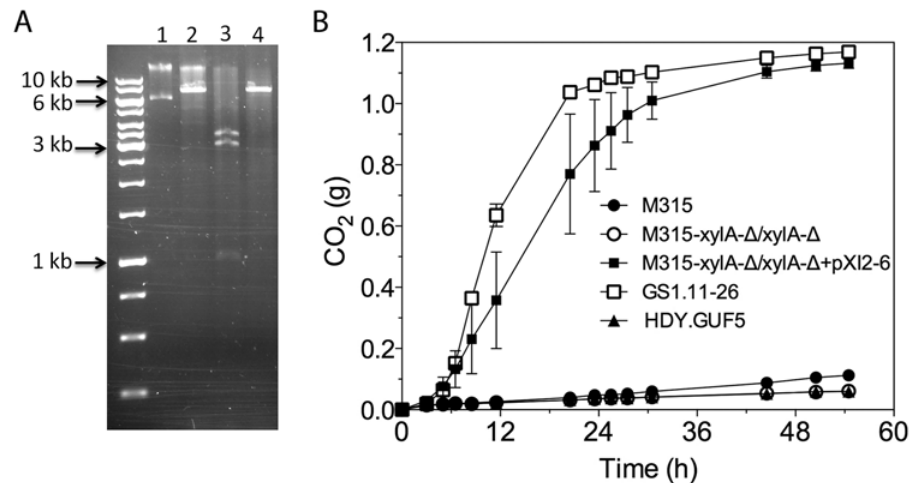
Fig 7. Restriction analysis and xylose fermentation conferring capacity of plasmid pXI2 – 6. (A) Restriction analysis of pXI2 – 6. Lane 1, undigested plasmid showing two bands that stand for the supercoiled (lower band) and nicked (upper band) structure; lane 2, Xho I digestion which has single restriction site but shows incomplete digestion; lane 3, Sph I and Sac I double digestion showing the expected 1kb, 3kb and 3.4kb band; lane 4, Hind III which has a single restriction site and produced the expected 7.4 kb band. (B) D- xylose fermentation performance of the mutant strain M315 expressing the plasmid pXI2 – 6 after deletion of the chromosomal XylA copies. Batch fermentation was performed in YP medium containing 4% xylose using standing fermentation bottles. The CO 2 production was estimated from the weight loss due to conversion of xylose to ethanol and CO 2 . Error bars represent standard deviation from the mean values of triplicate experiments.